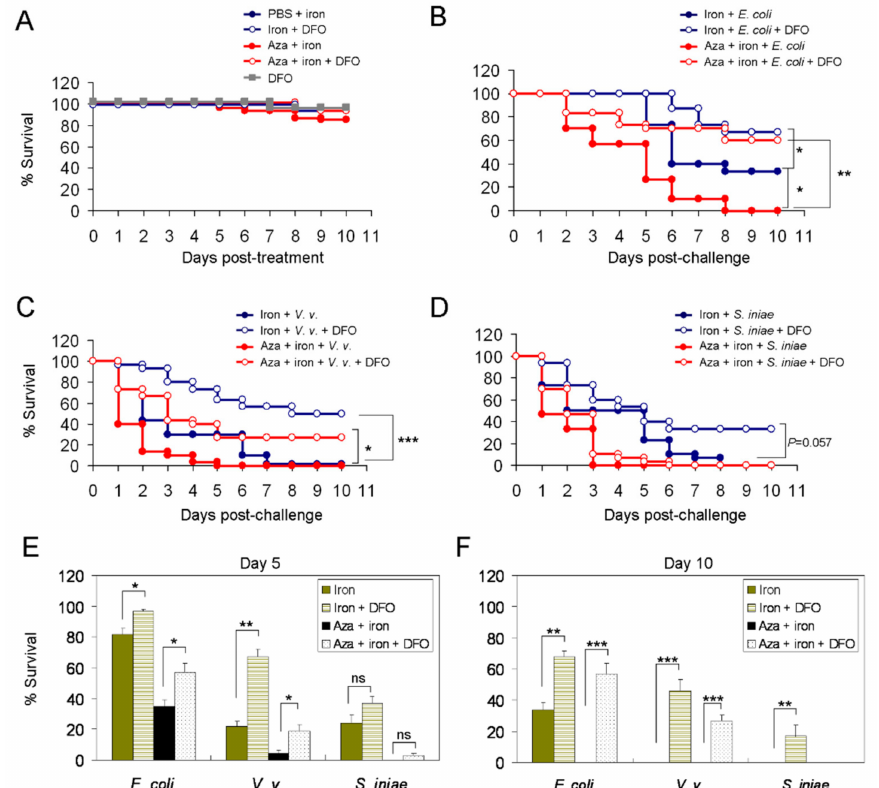
Figure 5. Increased susceptibility to bacterial infection in azacitidine-treated zebrafish in the presence of iron. The Kaplan–Meier survival curve of zebrafish pretreated with the indicated compounds, alone or in their combinations, for three days only ( A ), or followed by a challenge with ( B ) E. coli (10 7 CFU), ( C ) V. vulnificus (10 5 CFU) or ( D ) S. iniae (10 3 CFU), n = 30 for each group, analyzed by the Kaplan–Meier log rank test. The Day-5 ( E ) and Day-10 ( F ) survival rates are shown. Results are mean ± SD of three independent experiments. * p < 0.05, ** p < 0.01, *** p < 0.001, ns, not significant, by Student’s t